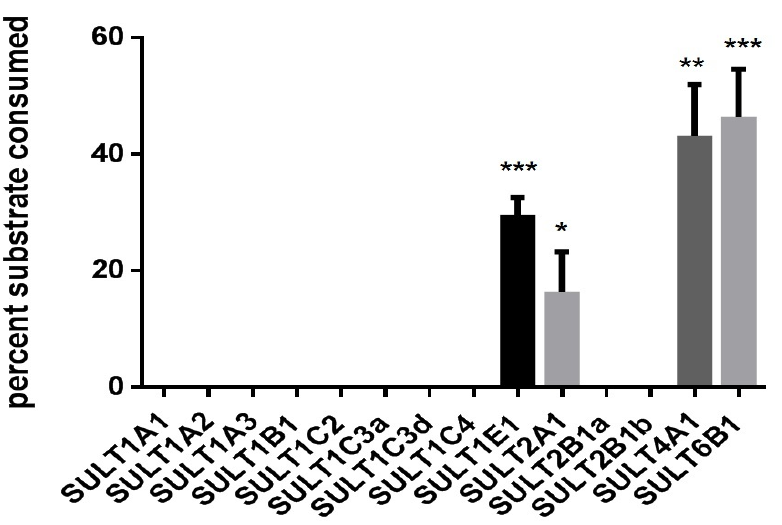
Figure 4. Activity of human SULT enzymes towards GSA. Enzyme bags were prepared from 14 fission yeast strains as indicated and activity was monitored by detecting luminescence. Data shown as percentage of substrate consumed after 3 h of reaction. Data shown were calculated from three independent experiments done in triplicate. * p < 0.05; ** p < 0.01; *** p < 0.001 vs. control (i.e., reaction samples without addition of PAPS).